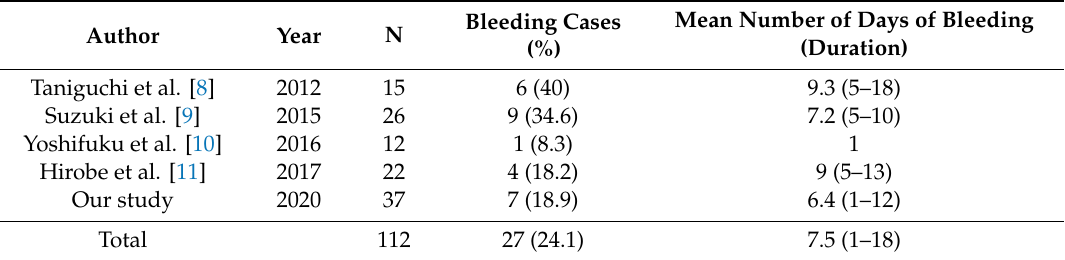
Table 4. Literature review of bleeding in partial glossectomy by the MCFP